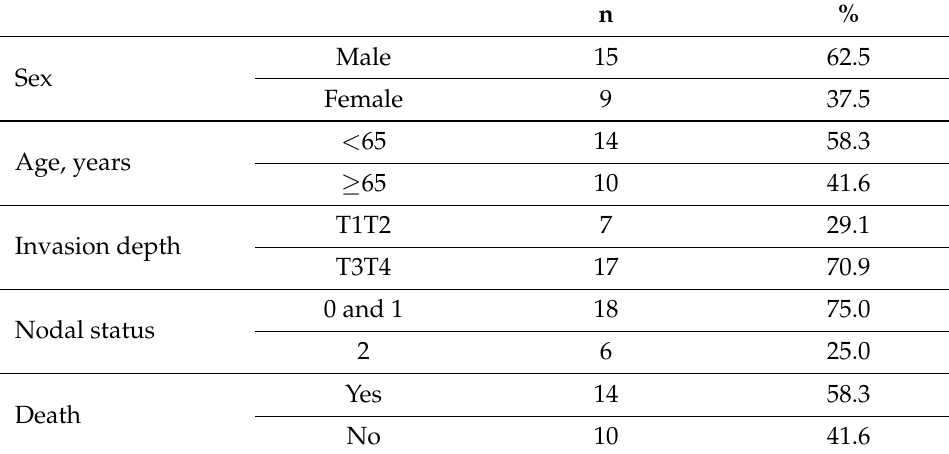
Table 2. Clinicopathological characteristics of the patient cohort eval for analysis. Note: because of the limited number of patients within every group, we merged T-stages 1 and 2; 3 and 4; and N 0, 1, and